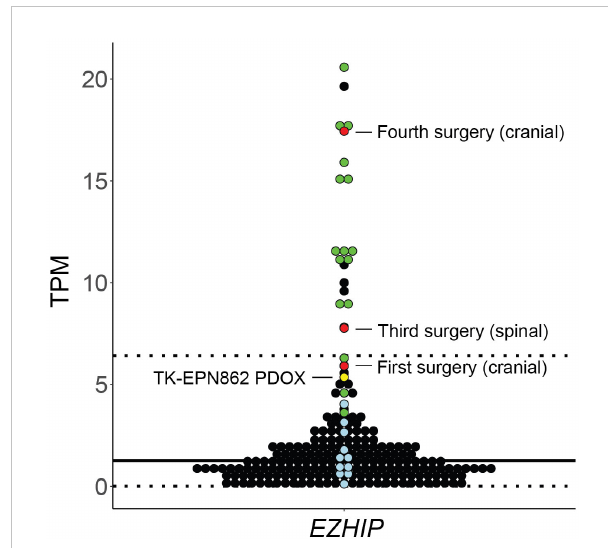
FIGURE 9 Gene expression levels (y axis: transcripts per million, TPM) for EZHIP in the fi rst, third and fourth surgical tumor samples and matched PDOX TK-EPN862 tumor. The patient tumors ( red ) and TK-EPN862 ( yellow ) are compared to a reference cohort containing high-risk pediatric brain tumors. PFA EPN ( green dots ), other non- PFA EPNs ( blue dots ), and all other brain tumors ( black dots ) from the reference cohort are shown. Solid black line shows the mean TPM of the reference cohort, and dotted line shows the TPM values that are two standard deviations away from the